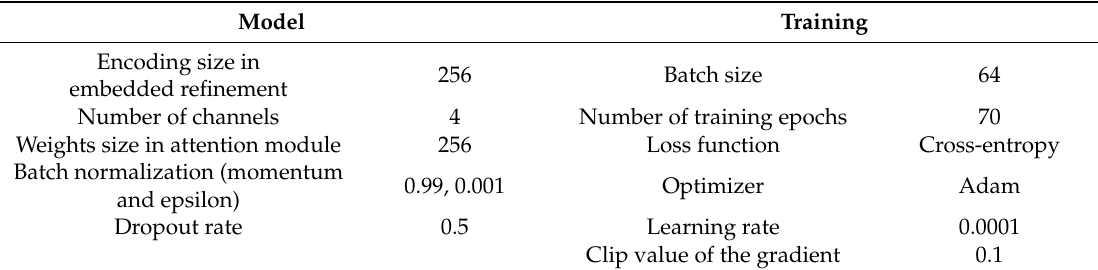
Table 3. Hyperparameters of the proposed neural network.